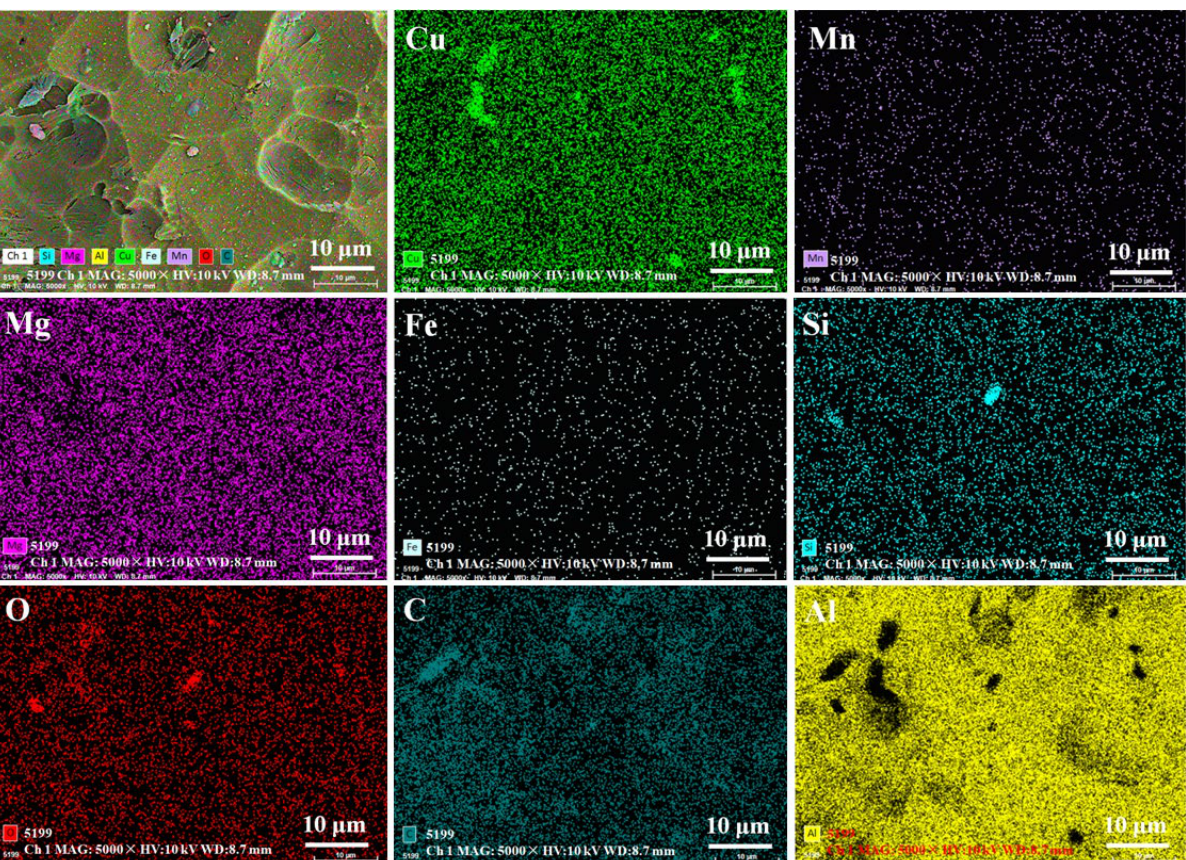
Figure 3. EDX mapping images of the stearic-acid-treated sample after Na 2 CO 3 -etching. Table 3. Chemical compositions of (a) untreated aluminum alloy, (b) NaOH-etched aluminum alloy etched aluminum alloy at 25 ◦ C, (e) stearic-acid-treated aluminum alloy after Na 2 CO 3